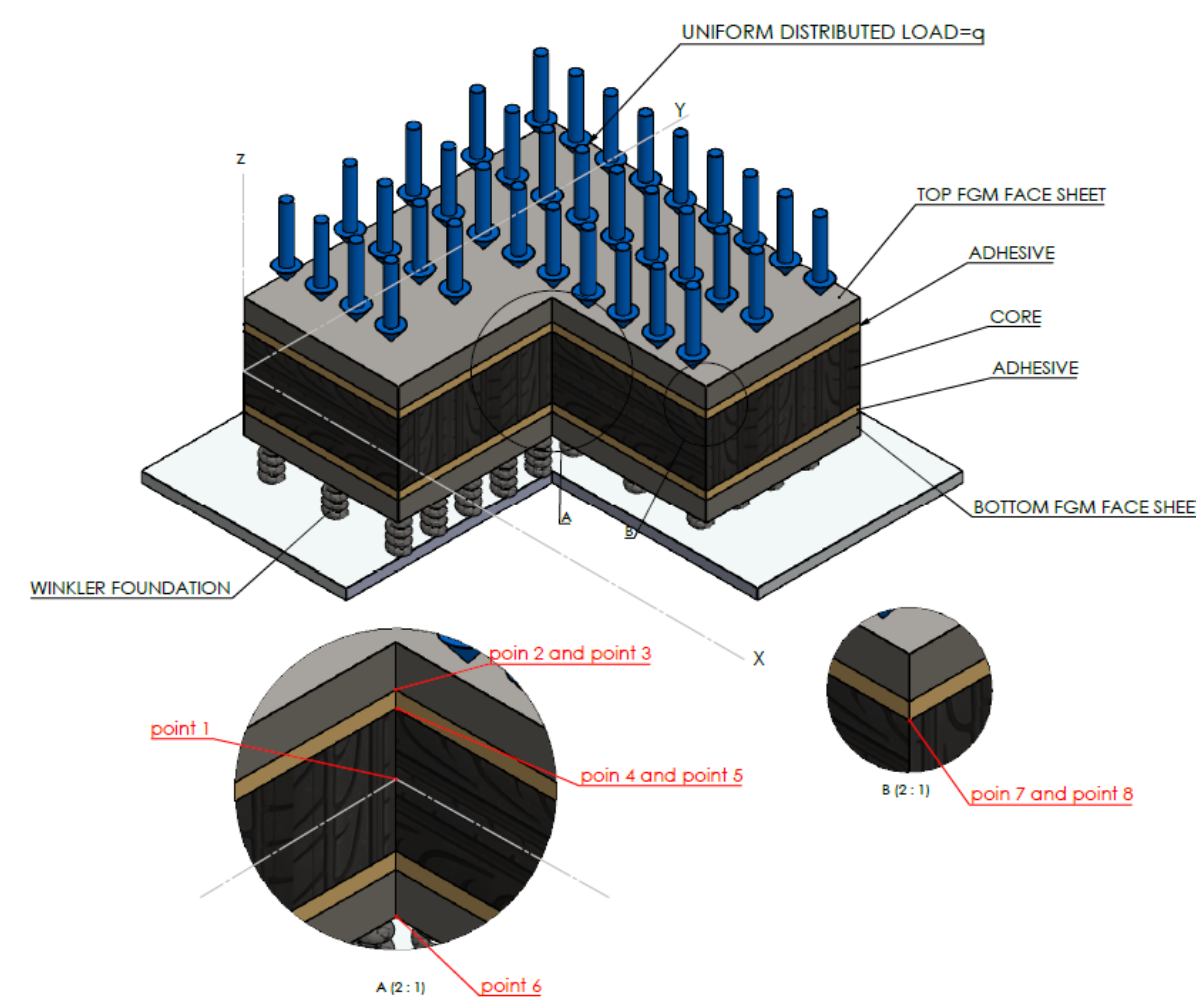
Figure 3. The geometric position of different points selected in the postulated model. Table 5. The geometric positions for 8 points are defined in tables according to the coordinate sys ‐ tem is shown in Figure 3.